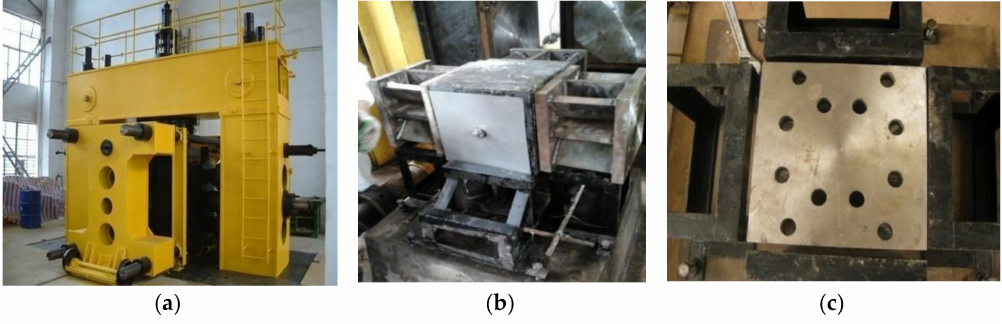
Figure 17. The main devices of the true tri-axial fracturing system. ( a ) Tri-axial loading system; ( b ) Force transmission frame; ( c ) Reserved holes of the acoustic emission (AE) sensor.